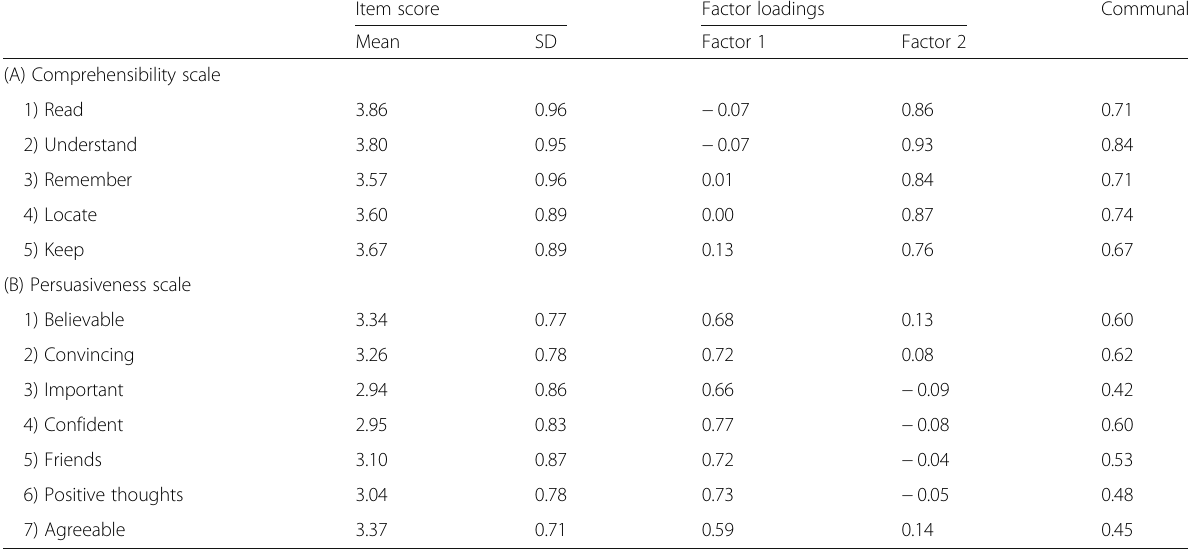
Table 2 Factor structure of the comprehensibility and persuasiveness